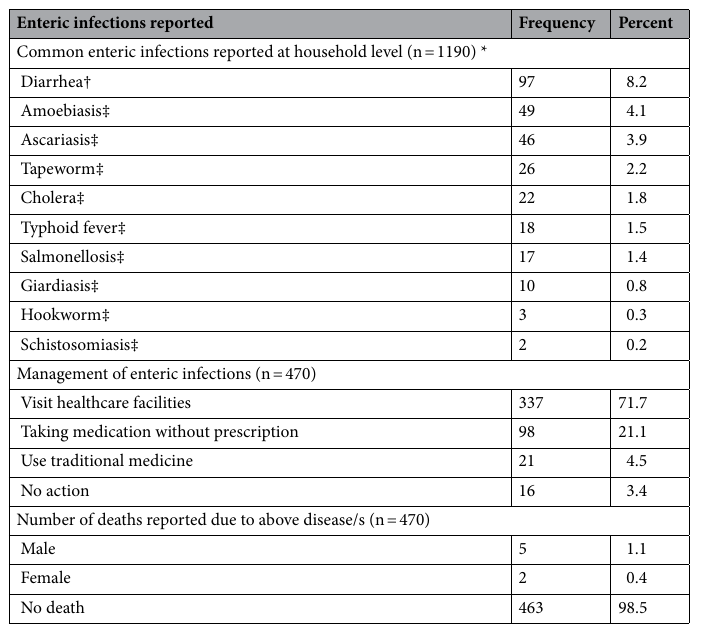
Table 3. Enteric infections, management practice, and associated deaths among communities in a rural northwest Ethiopia, May 2016. *There were households who reported two or more enteric infections. † Self- reported. ‡ Checked from medication